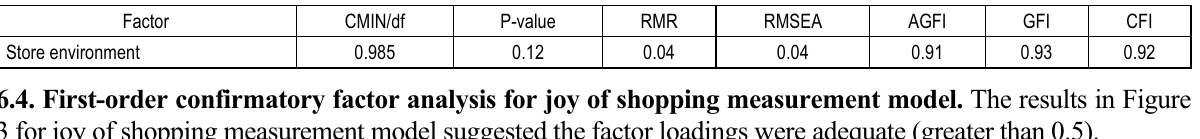
Table 3. Goodness of fit indices for store environment measurement model